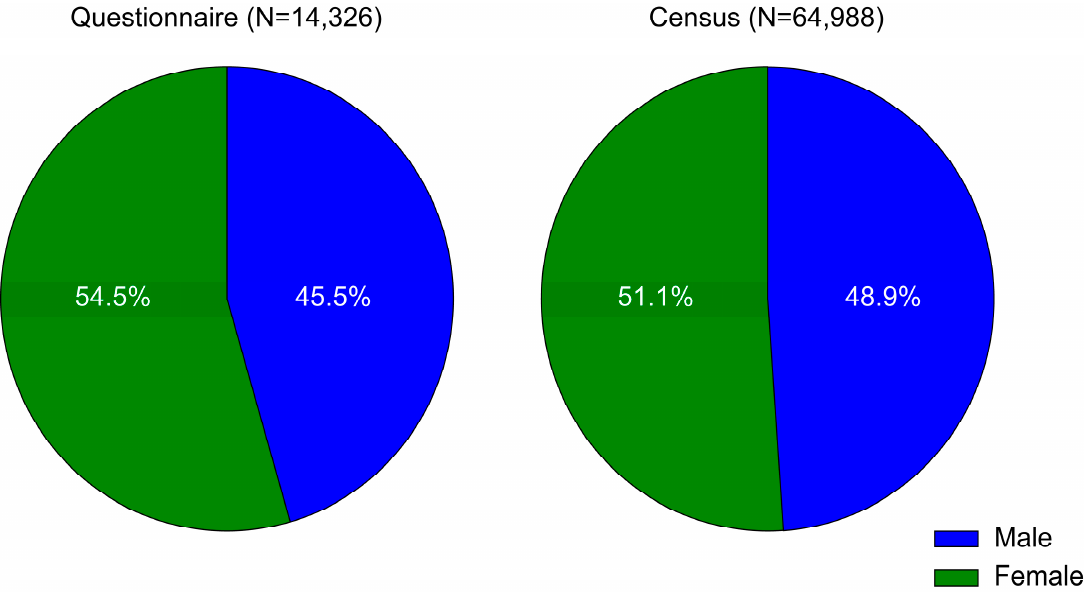
Figure 2. Sex composition ratio comparison between the survey and the census.